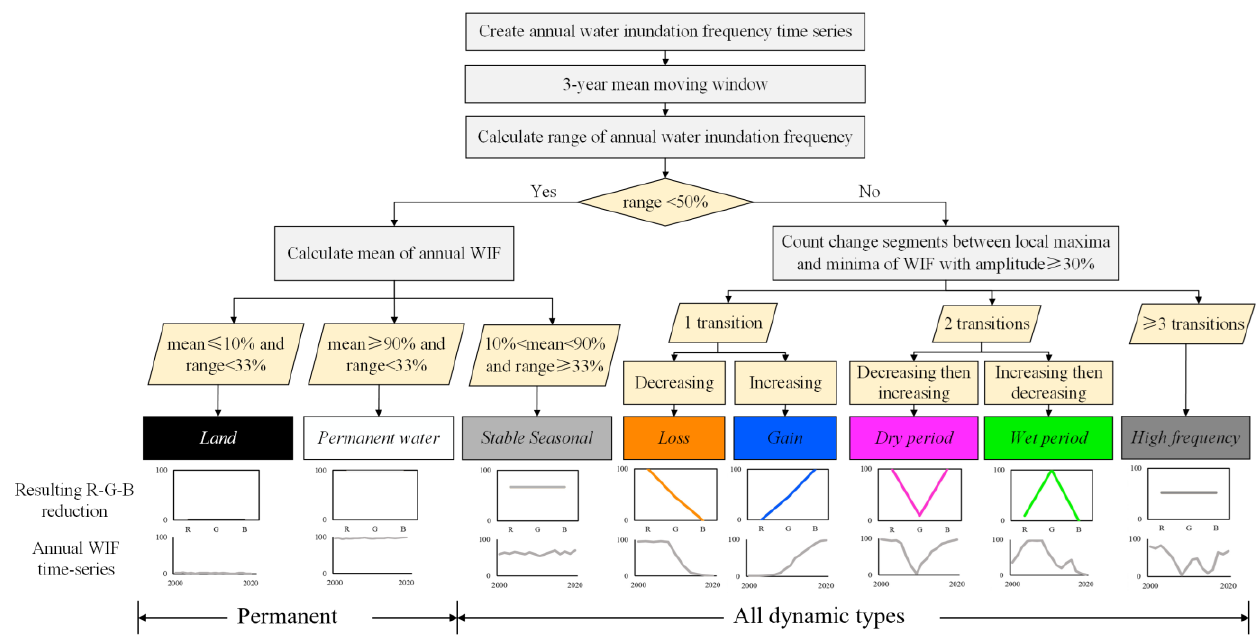
Figure 4. The workflow of surface water time-series analysis and resulting dynamic types for each 30 m × 30 m pixel in the GBA. (Transition means change in alternating direction between local maxima and minima value of annual WIF).